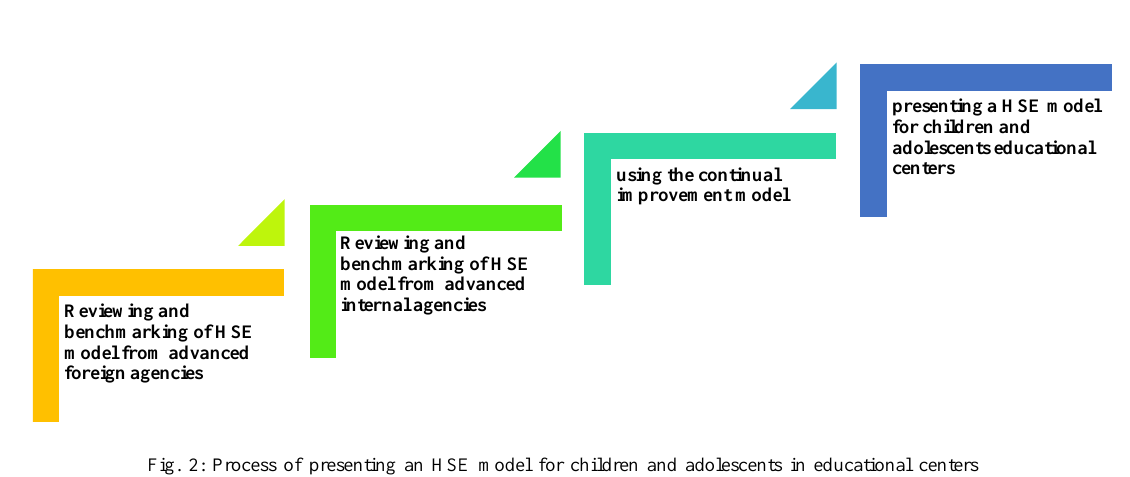
Fig. 2: Process of presenting an HSE model for children and adolescents in educational